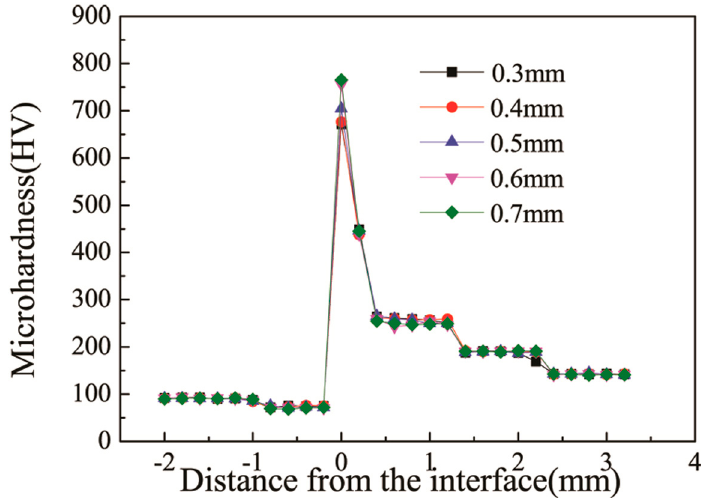
Figure 12. Microhardness distribution in the Al/steel butt joints.